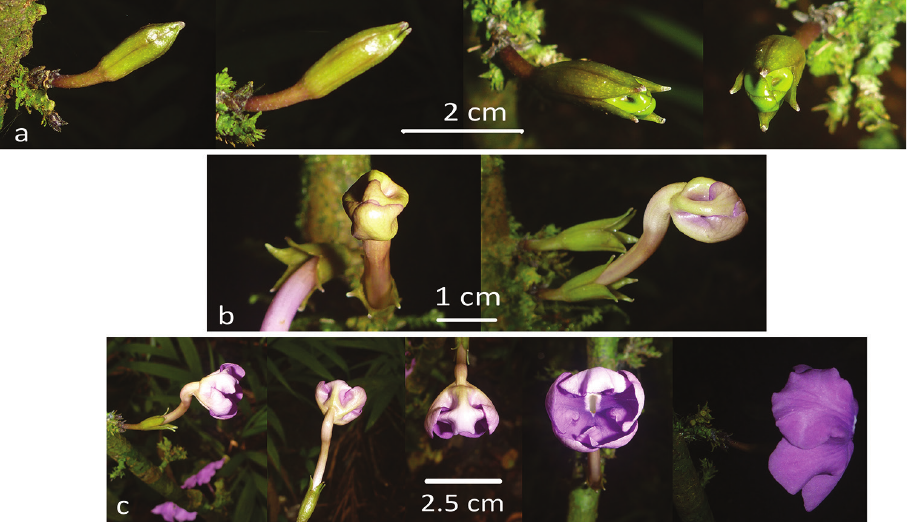
Figure 4. Estivation of Brunfelsia cabiesesiana . A calyces in bud. (day 1–3) B emerging flower. (day 4–5) C petals unfold (day